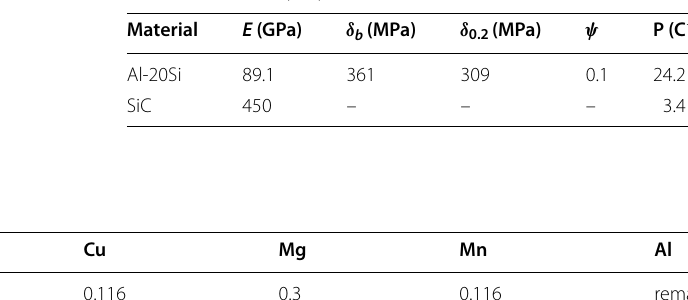
Table 4 Material properties of